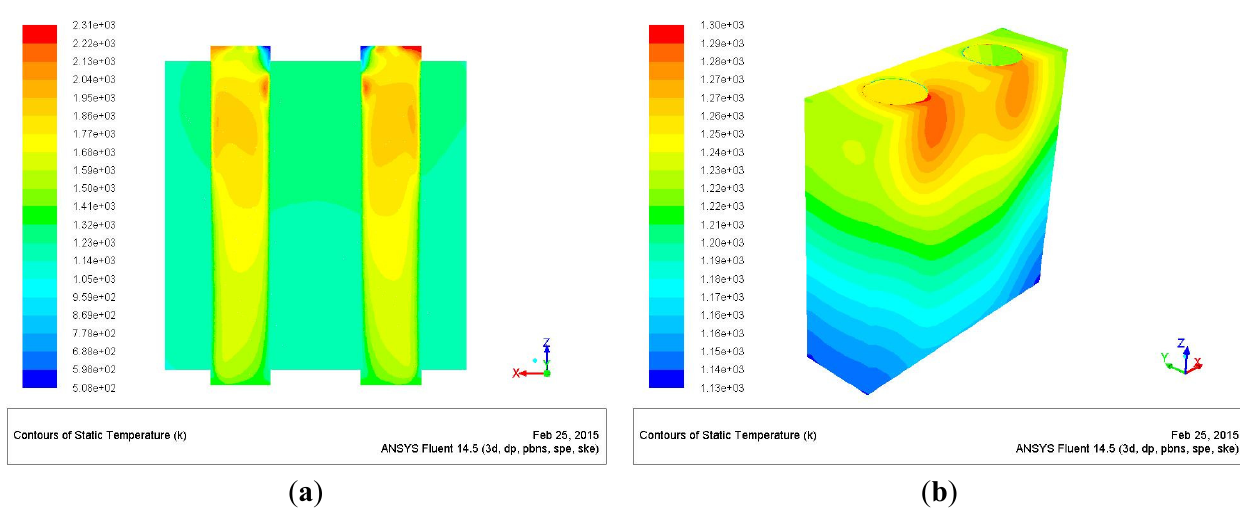
Figure 11. Temperature map on the XZ plane ( a ); temperature map on the emitting surfaces ( b ). The maximum temperature, inside the chambers, is predicted to be close to 2310 K.